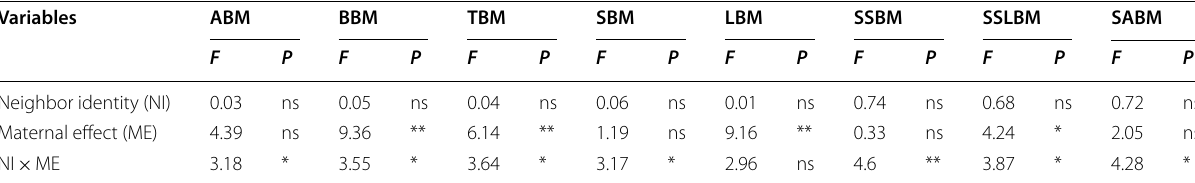
Table 1 Results of linear models assessing the effects of neighbor identity and maternal effect induced by grazing on aboveground biomass (ABM), belowground biomass (BBM), total biomass (TBM), stem biomass (SBM), leaf biomass (LBM), leaf biomass of a single plant (SLBM), stem biomass of a single plant (SSBM), and aboveground biomass of a single plant (SABM)